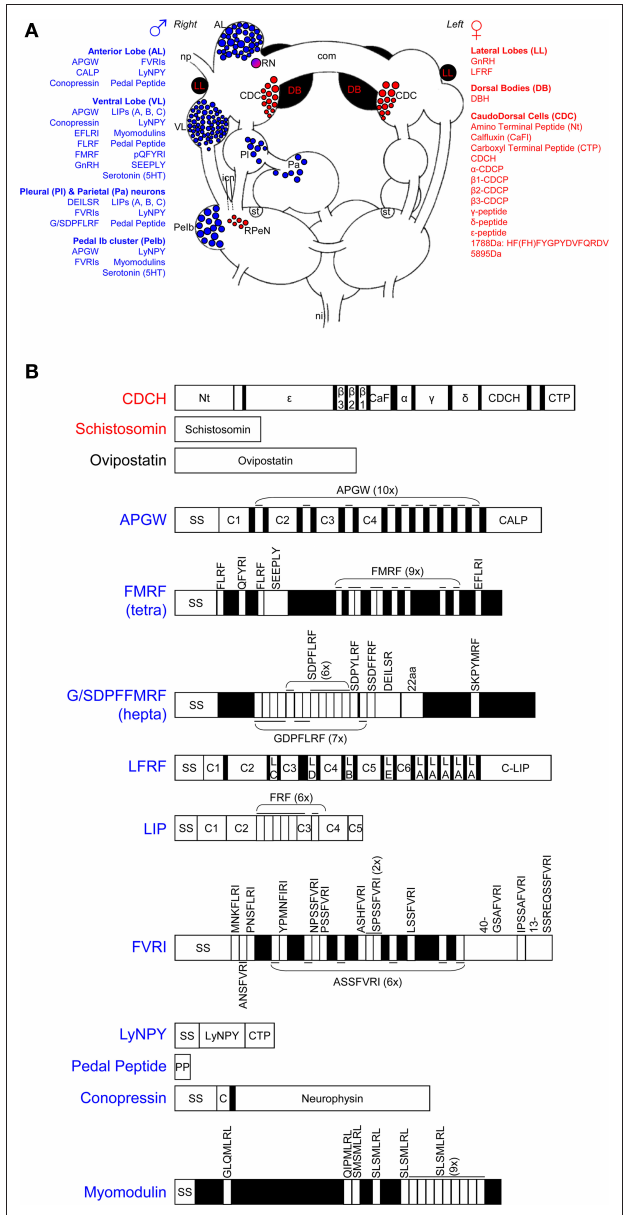
Figure 1 | Neuro-endocrine regulation of male and female reproduction in Lymnaea stagnalis. (A) Schematic drawing of the involved ganglia of the central nervous system. The blue and red areas show, respectively, the neuronal clusters that are involved in male and female reproduction. The substances involved in male reproduction are also indicated in blue; the female ones are listed in red. com, cerebral commissure; icn, inferior cervical nerve; ni, nervus intestinalis; np, nervus penis; RN, ring neuron; RPeN, right pedal neurons; st statocyst. This figure is adapted from Jarne et al. (2010). (B) Overview of the identified neuropeptides and proteins involved in reproduction. SS stands for signal sequence, numbered Cs stand for different connecting peptides, all the other peptides can be found in (A) of the figure. See text and Table 1 for further details and